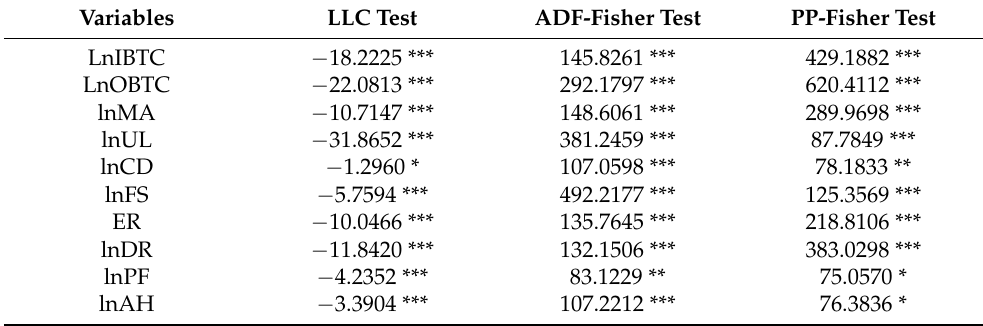
Table 9. Unit root